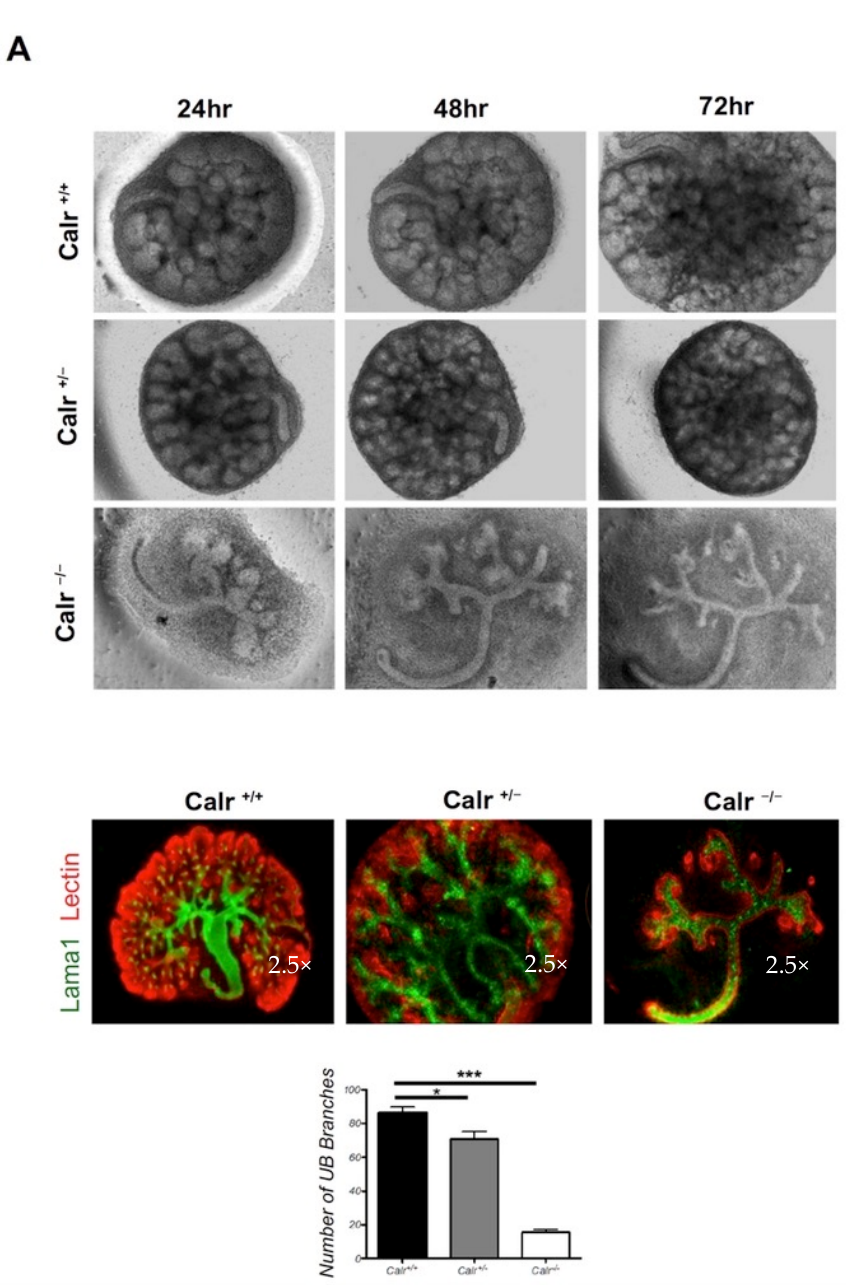
Figure 2. Calr − / − mouse kidney rudiments display a severe alteration in growth and UB branching. ( A ): Kidney rudiments from Calr +/+ Calr +/ − and Calr − / − (E13.5) were isolated and cultured ex vivo for three days. Calr − / − kidney rudiments showed an overall alteration in growth and a significant alteration in ureteric bud branching. ( B ): Immunofluorescence staining of kidney rudiments after three days of culture. A co-staining of laminin (red) and DBA lectin (green) was performed to visualize the different structure of the rudiments. The branching quantification was achieved by counting the number of branches of the ureteric bud. The quantification is presented as a bar chart with error bars. Each bar represents the branch’s number means ± s.d. from six cultured rudiments. Significant differences: (*) p < 0.05, (***) p < 0.001.